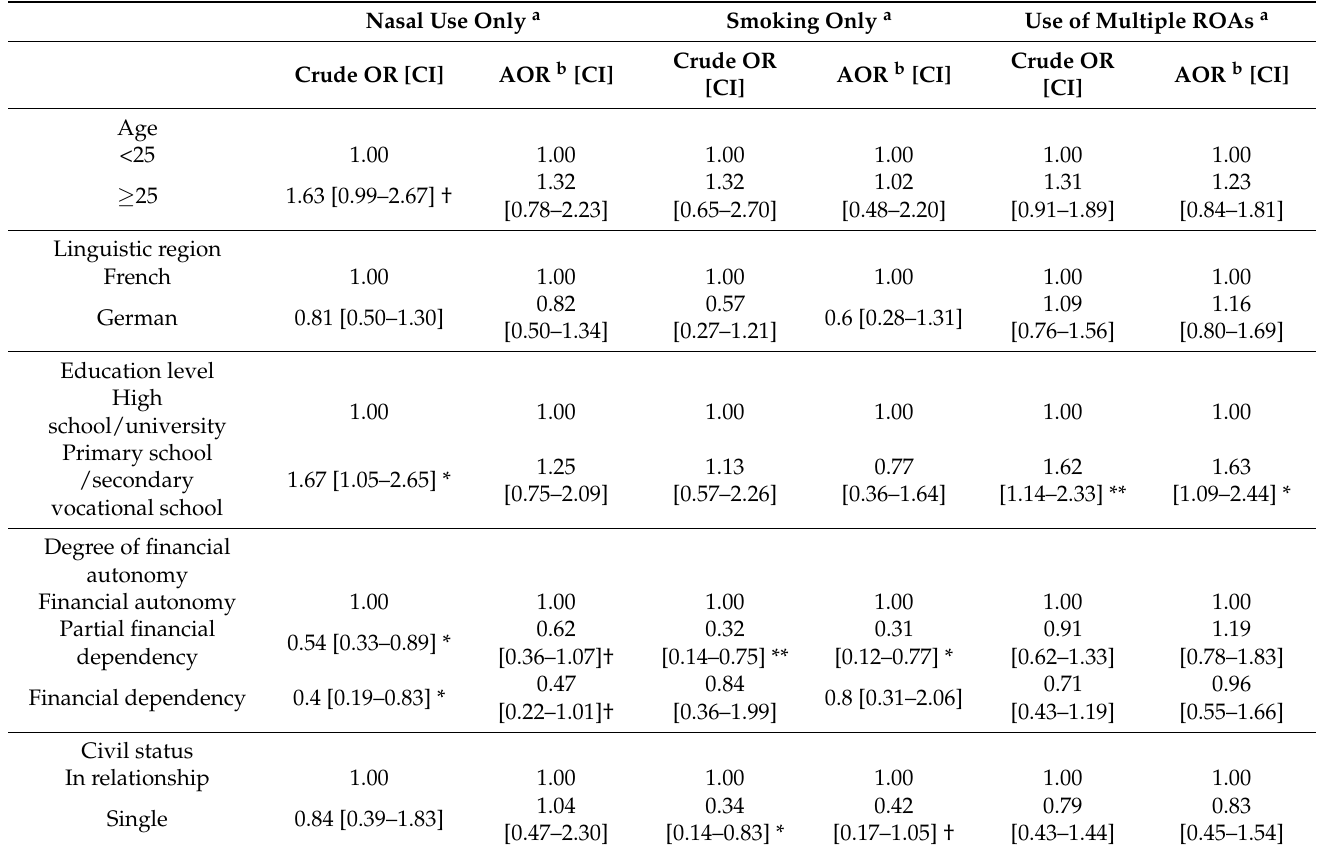
Table 4. Multinomial logistic regression analyses with routes of administration as outcome. The analyses were performed for users of any of the 18 illicit